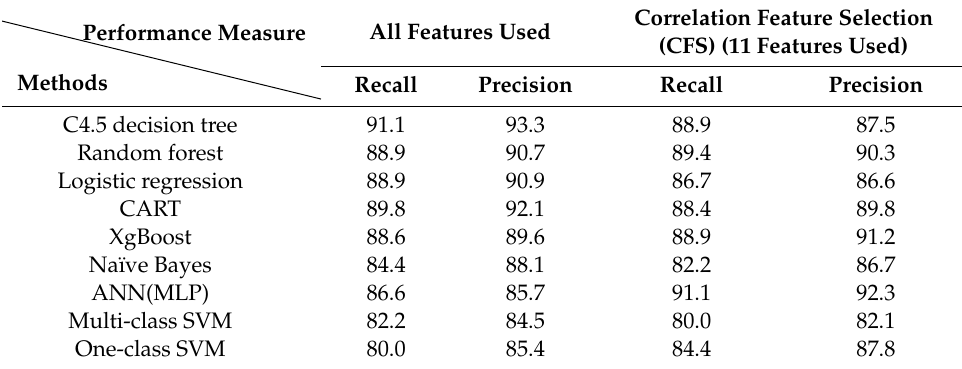
Table 9. The performance measurement for stroke severity prediction accuracy